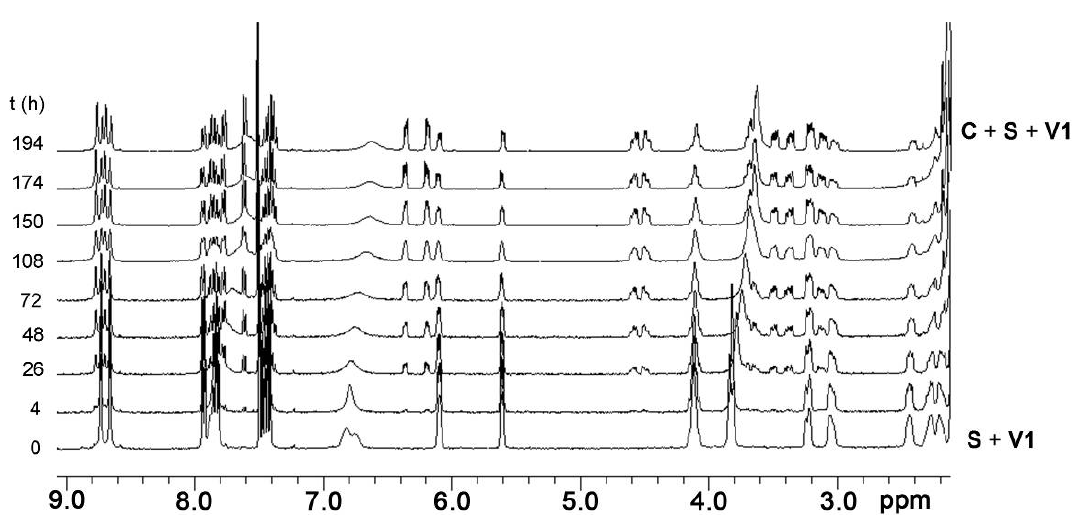
Figure 6. Series of partial 400 MHz 1 H-NMR spectra recorded over time, revealing the decrease in population of isomer S at the expense of the population of isomer C in the presence of 1.3 equiv. of V1 at 37.5 °C in CDCl